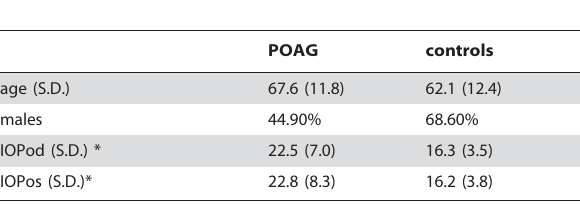
Table 2. Clinical and demographic characteristics of case and control individuals .